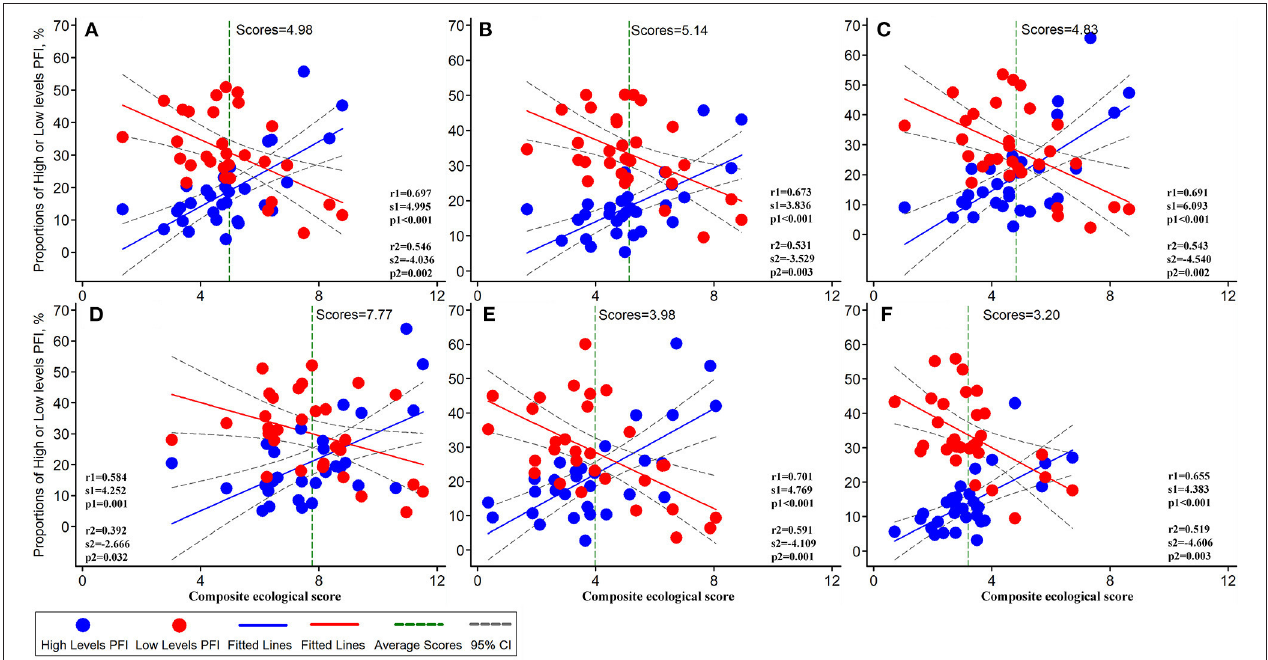
FIGURE 2 | Distribution for proportions of high or low PFI with the scores of ecological correlates at the provincial level. (A) Total. (B) Boys. (C) Girls. (D) 10-12y. (E) 13-15y. (F) 16-18y. Each dot represents a province with the red dot for low-PFI levels and the blue dot for high PFI. The r represents a correlation coefficient, s denotes the slope rate (or rate of change) of the fitted curve, and the p -value indicates the level of statistical significance. Dotted green lines indicate the average scores of ecological